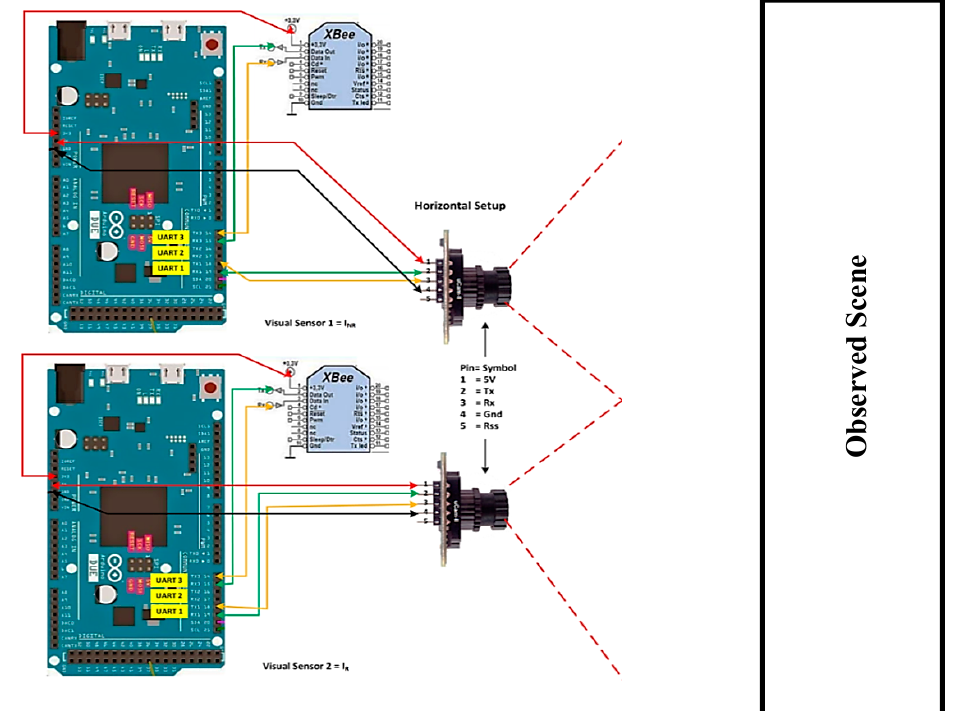
Figure 10. Proposed multi-visual setup.